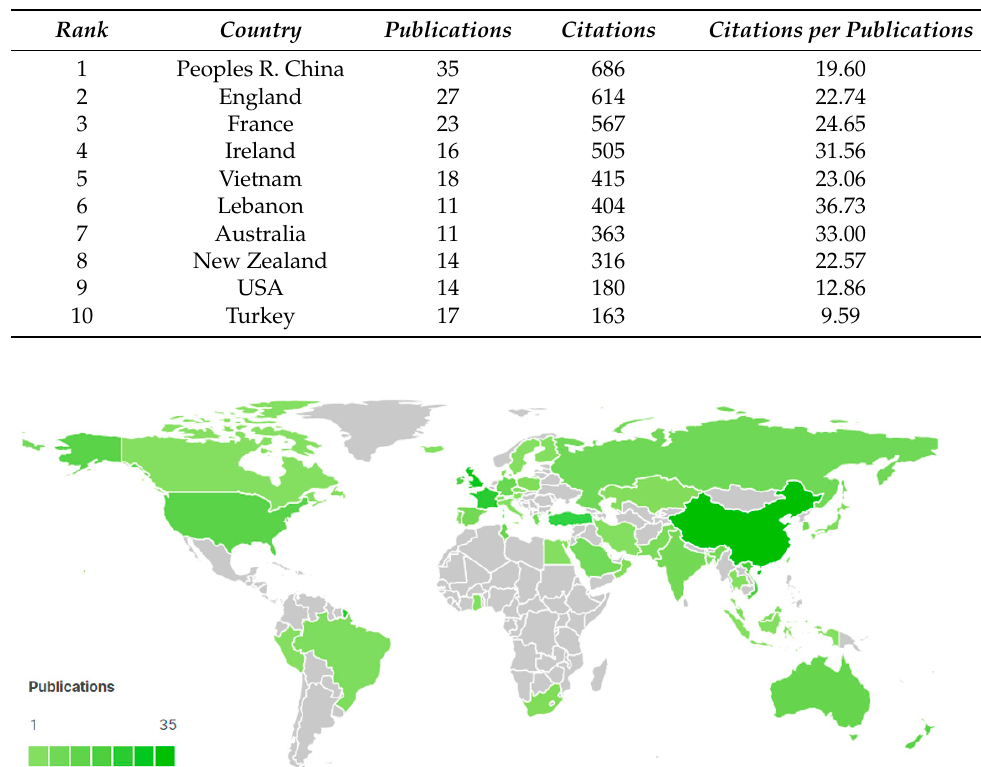
Figure 6. Publications by country world map.